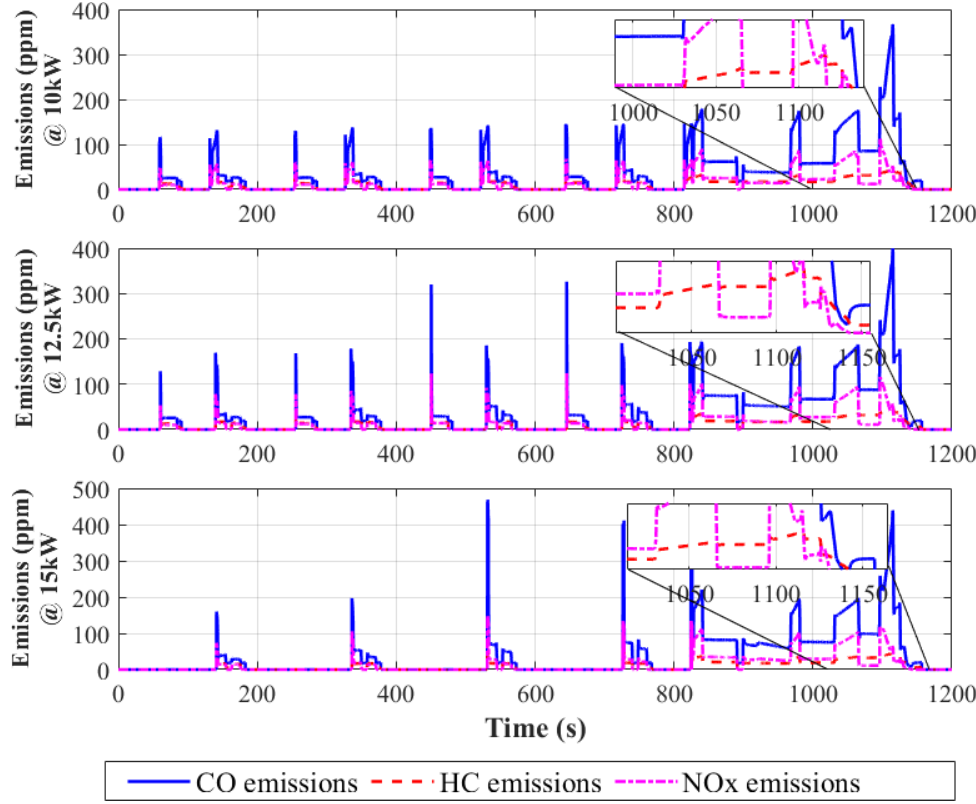
Figure 8. Fuel comparison on NEDC drive cycle according to the power request.